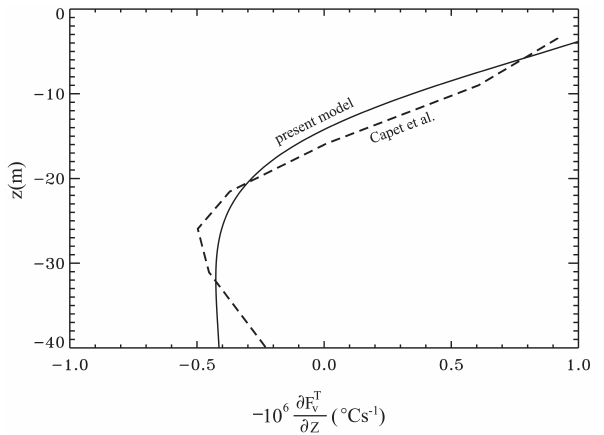
Fig. 3. Absolute value of the mean velocity considered in the present analysis which corresponds to the case of a down-front wind and which is given by Eqs. (8a,b), (12b) (solid curve) and the one computed in ICC0 simulation of Capet et al. (2008) (dashed line which is taken from their Fig.